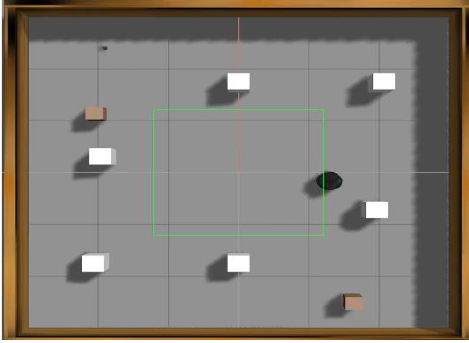
Figure 7. DQN simulation in the Gazebo.